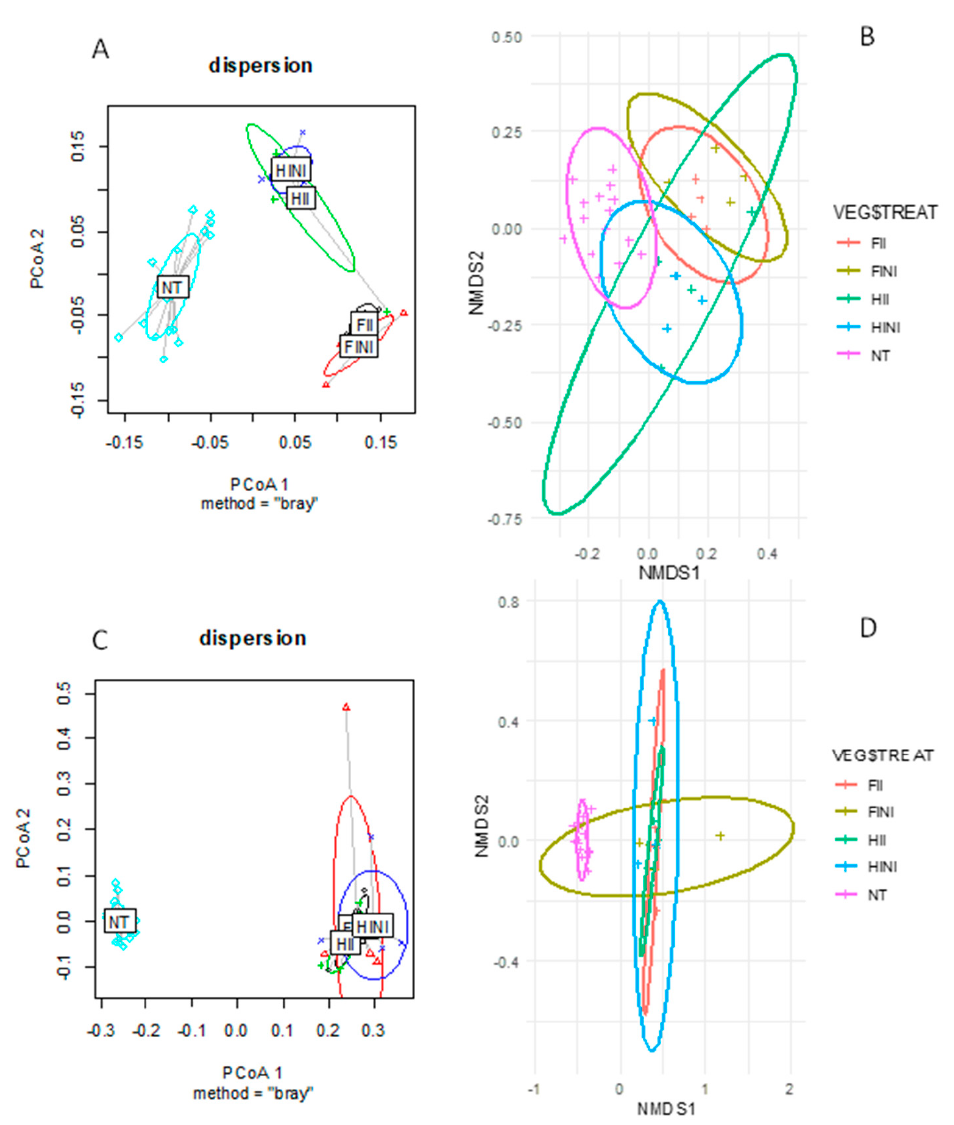
Figure 2. Principal coordinates analysis (PCoA) of the Bray-Curtis distance matrix for bacteria ( A ) and fungi ( C ) communities and the non-metric multidimensional scaling (NMDS) plot of Bray-Curtis dissimilarities for bacteria ( B ) and fungi ( D ) communities from vineyard soils subjected to different irrigation amounts (FI, fully irrigated, or HI, half irrigated), AMF inoculation (I, inoculated, or NI, non-inoculated) and their combinations.